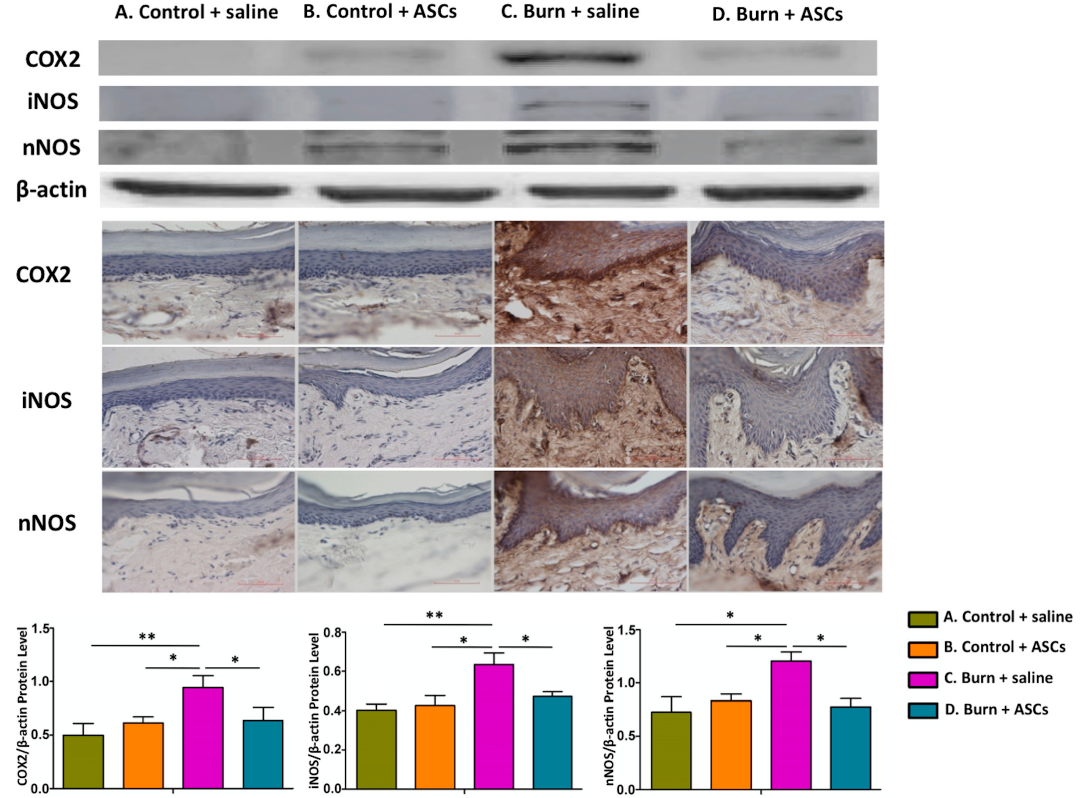
Figure 4. Attenuated local inflammation in post-burn hind paw skin after ASC transplantations. Four weeks after subcutaneous ASC transplantation or saline injection into the post-burn hind paw skin, immunohistochemical staining and western blotting of skin samples revealed significantly increased levels of inflammatory proteins (COX-2, iNOS and nNOS) in Group C, compared with Groups A and D. This indicated that a burn injury could induce local inflammation, which could be attenuated by ASCs. Upper four rows: Representative western blot images. Middle: Representative immunohistochemical staining images. Bottom: Quantitative analyses of the western blotting data. The sample size was n > 3 per test and β -actin was used as the internal protein control. (** p < 0.01, * p < 0.05).